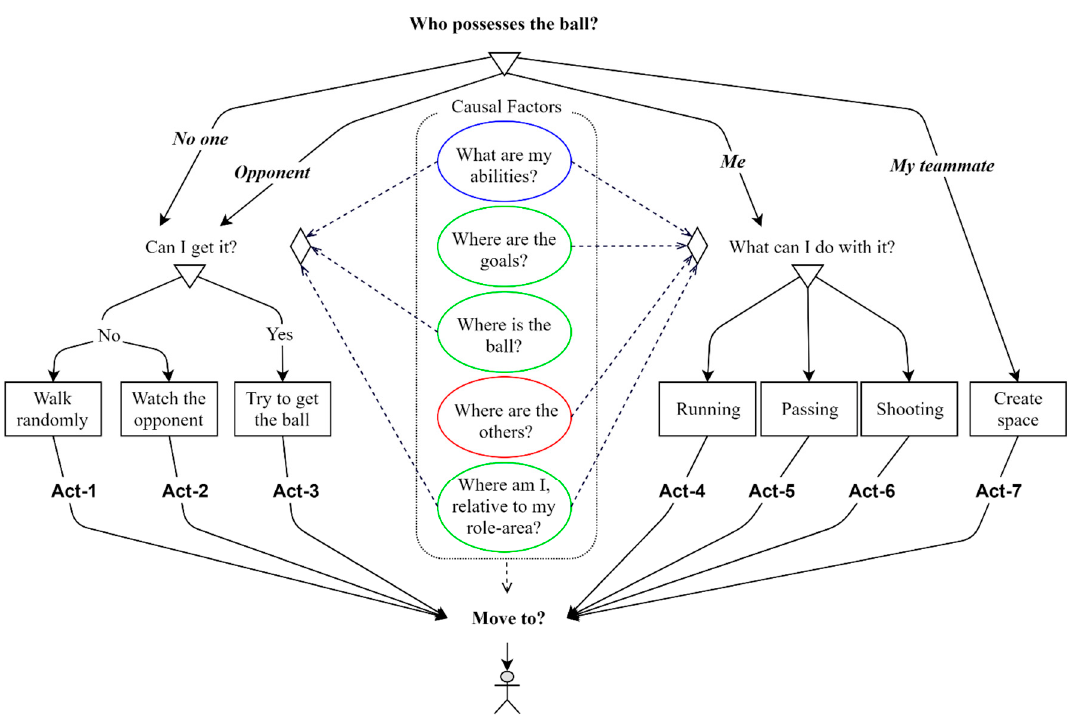
Figure 6. Schematic representation of football players’ movement decision based on the proposed agent-structure in Figure 3. In total, three sets of causes of movement (zero-order, first-order, and second-order factors) are represented in blue, green, and red colour, respectively.